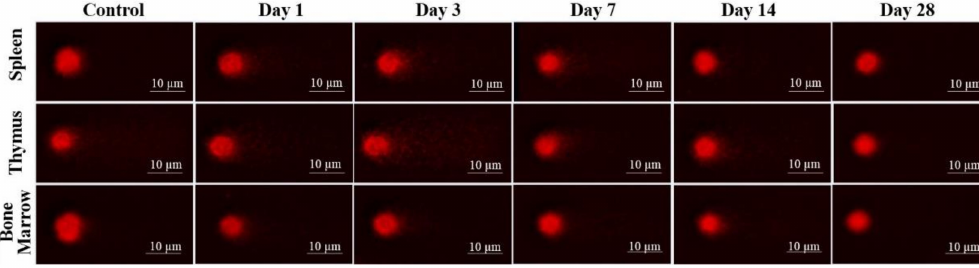
Figure 9. DNA fragmentation detected in spleen, thymus, and bone marrow (BM) cells by comet assay after low energy ultrashort-pulsed electron beam irradiation in vivo of rats. Scale bar is 10 µ